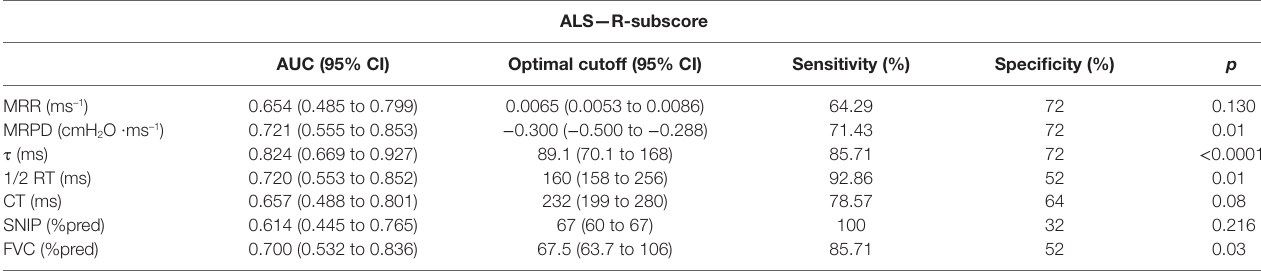
AUC, area under curve; CI, confidence interval; MRR, maximum relaxation rate, MRPD, maximum rate of pressure development; τ , tau; 1/2RT, half-relaxation time; CT, contraction time; SNIP, sniff nasal inspiratory pressure; FVC, forced vital capacity; ES, effect size; %pred, percentage of predicted; cmH 2 O, centimeter of water; ALS, amyotrophic lateral sclerosis.